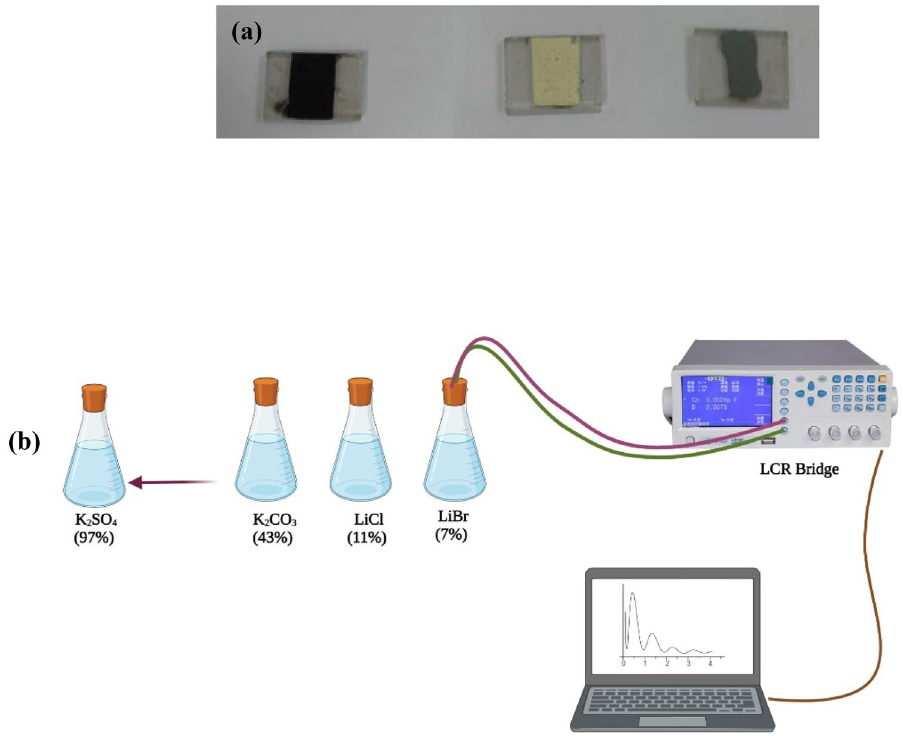
Figure 2. ( a ) The photograph of humidity sensor and ( b ) The humidity sensing testing setup using saturated salt